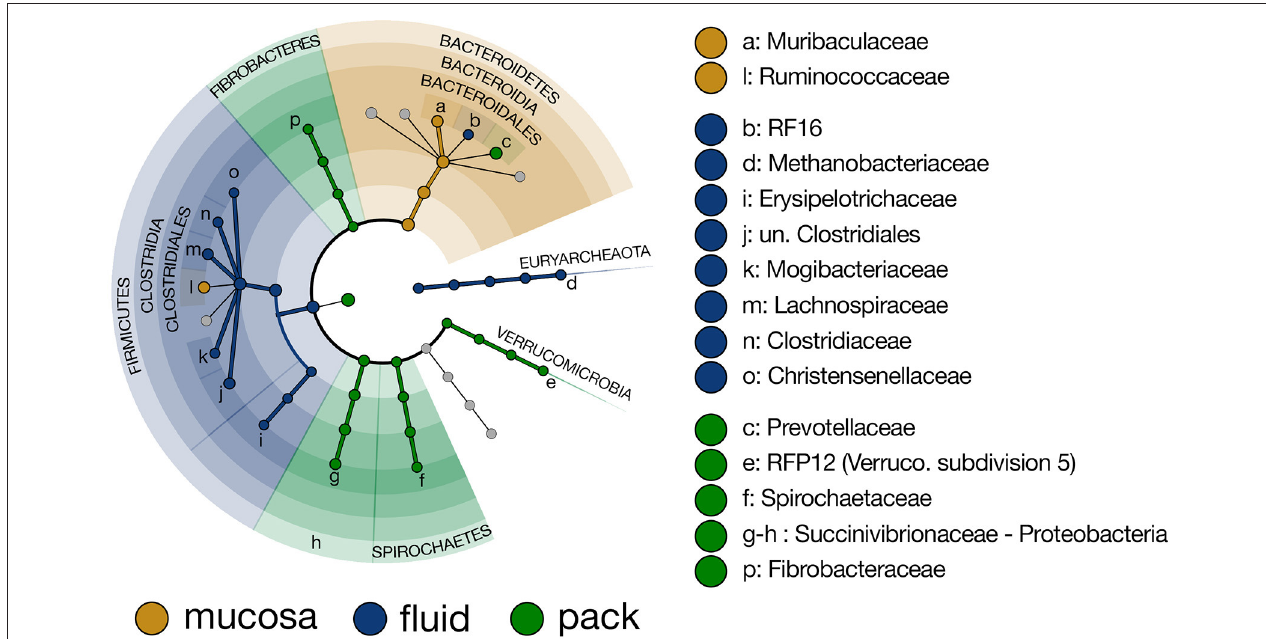
FIGURE 4 | Cladogram demonstrating the microbial families with relative abundances of > 0.5% of the total community across fluid, pack, and mucosa-associated microbial communities. Taxa discriminant of fluid communities are highlighted in blue, taxa discriminant of pack communities are highlighted in green, and taxa discriminant of mucosa communities are highlighted in gold (LEfSe, p < 0.01, n = 12).